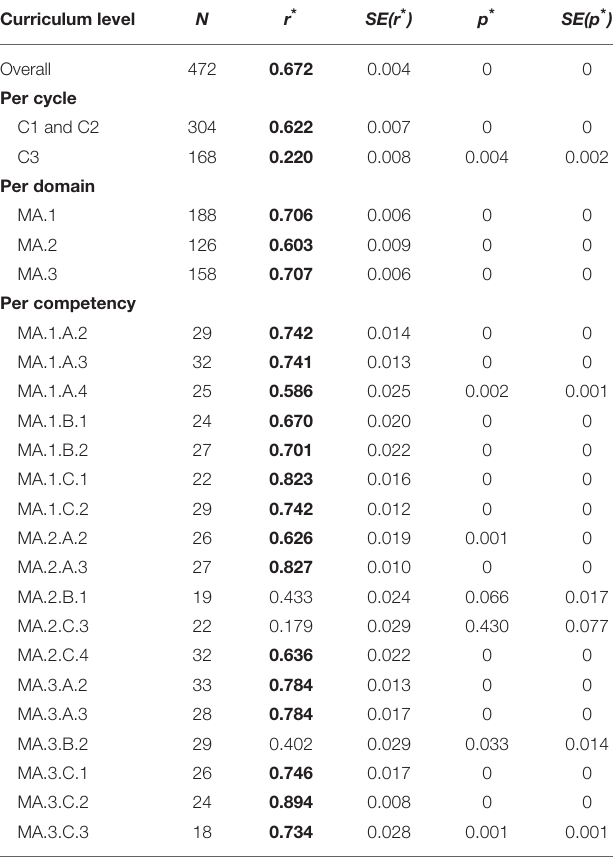
TABLE 6 | Estimated pearson correlation coefficients between CRD and difficulty estimates from the concurrent calibration over all items, per cycle, per domain, and per